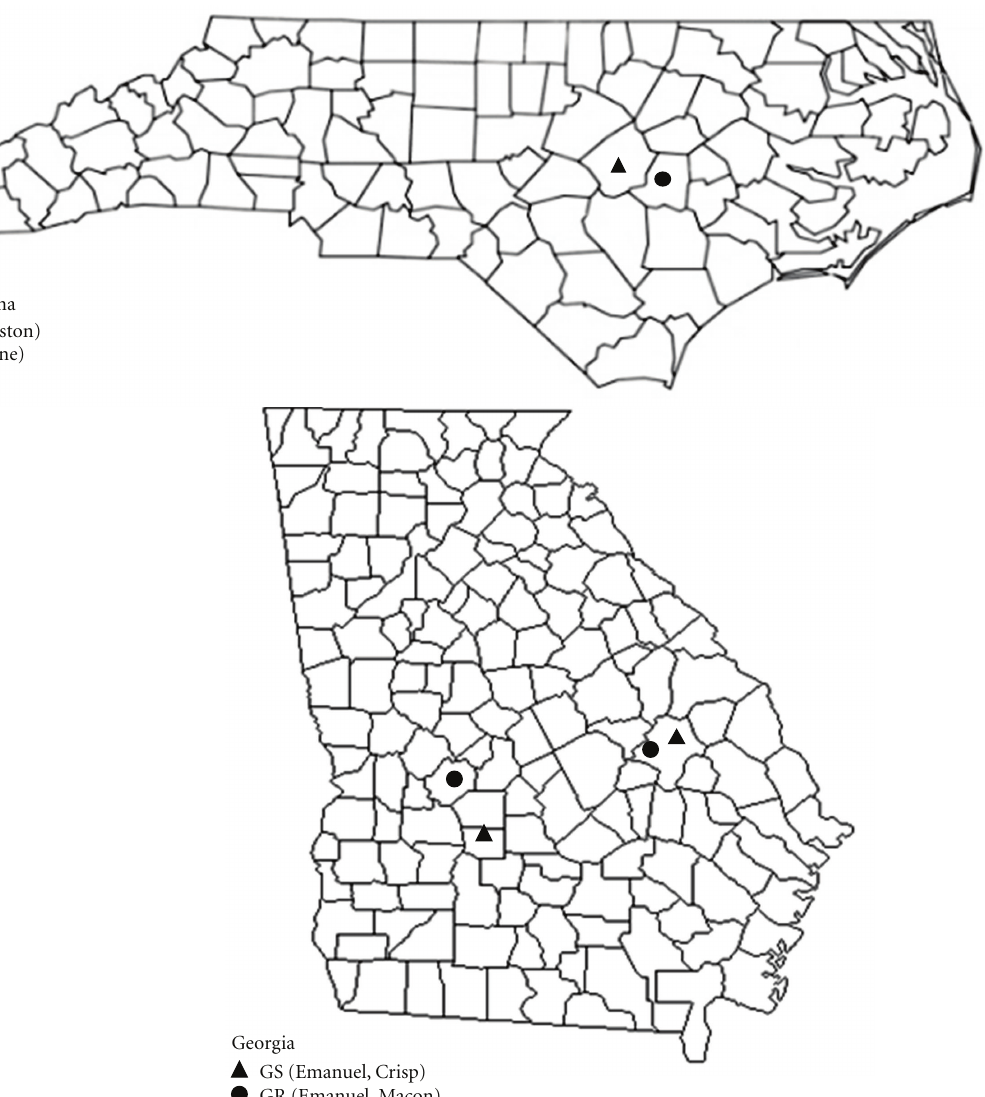
Figure 1: Locations of North Carolina and Georgia biotypes used in the